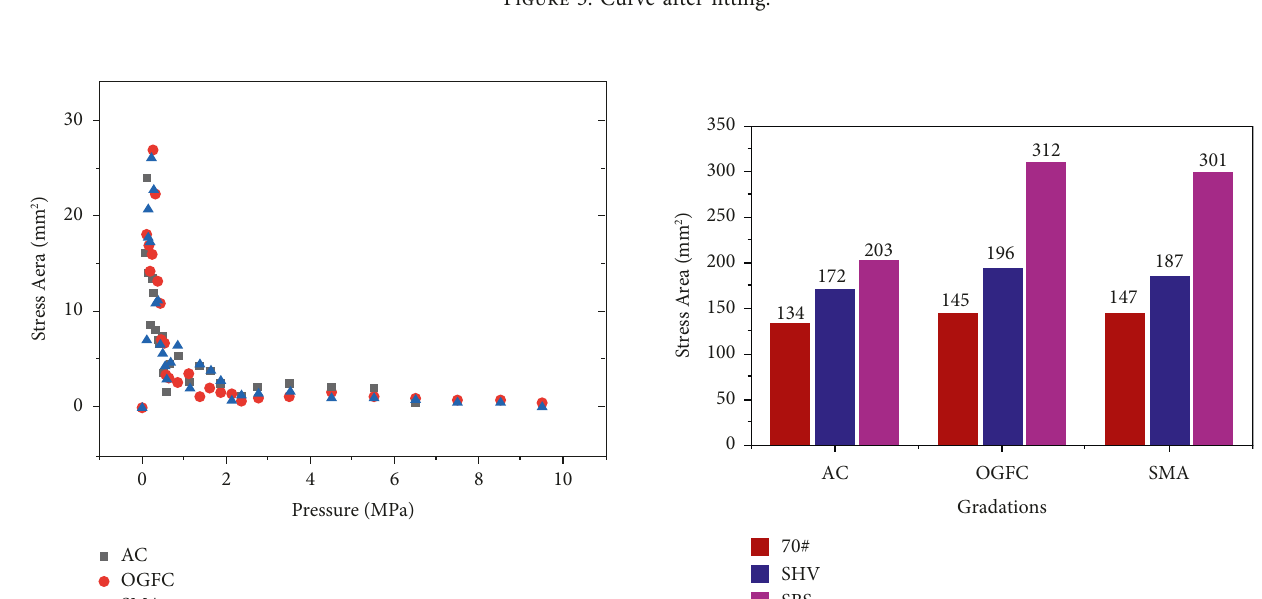
Figure 5: Curve after fitting.